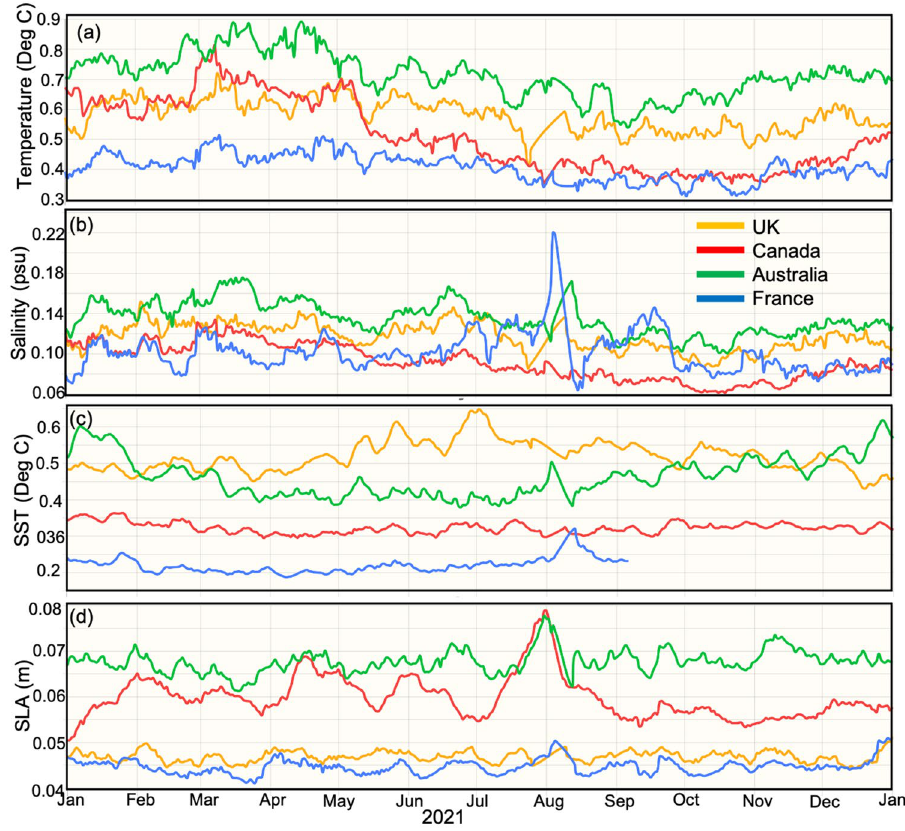
Figure 2. A demonstration of the precision of analyses from contemporary ocean forecast systems. Time series of RMSD between observed and analysed ( a ) subsurface temperature, ( b ) subsurface salinity, ( c ) surface temperature, and ( d ) sea-level anomaly for four different operational ocean forecast systems in the Australian region. The four systems include the operational short-range forecast systems from the UK 8 , Canada 41 , Australia 42 , and France 43 . These figures were accessed from https:// seedr agon. org on 13 December 2022, are were produced under OceanPredict (https:// seedr agon. org) to inter-compare “class 4” metrics between operational systems 11,44